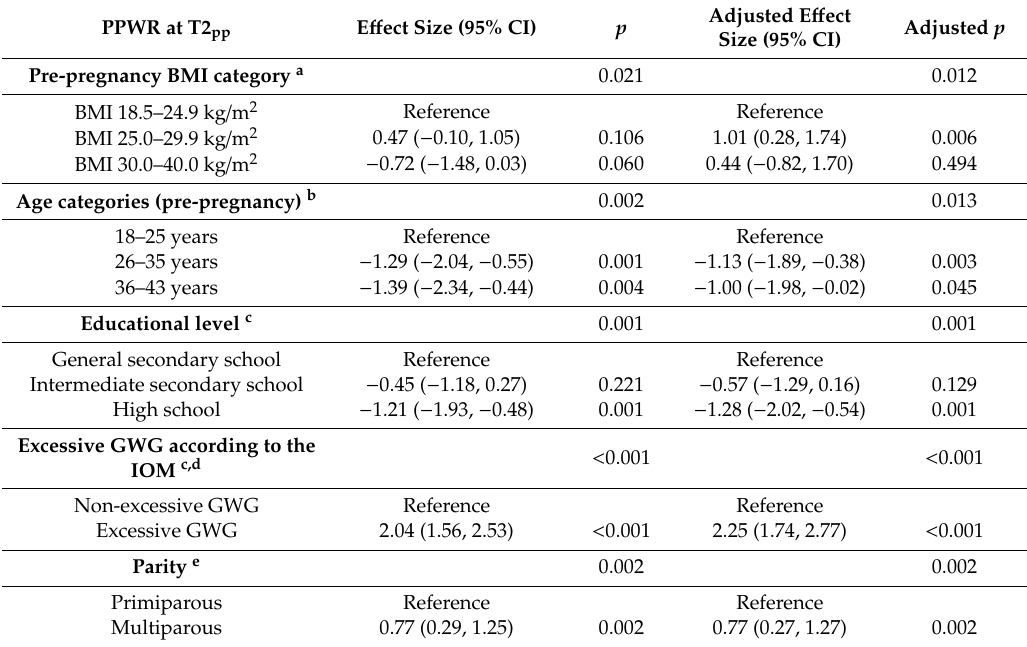
Table 4. Predictors of long-term